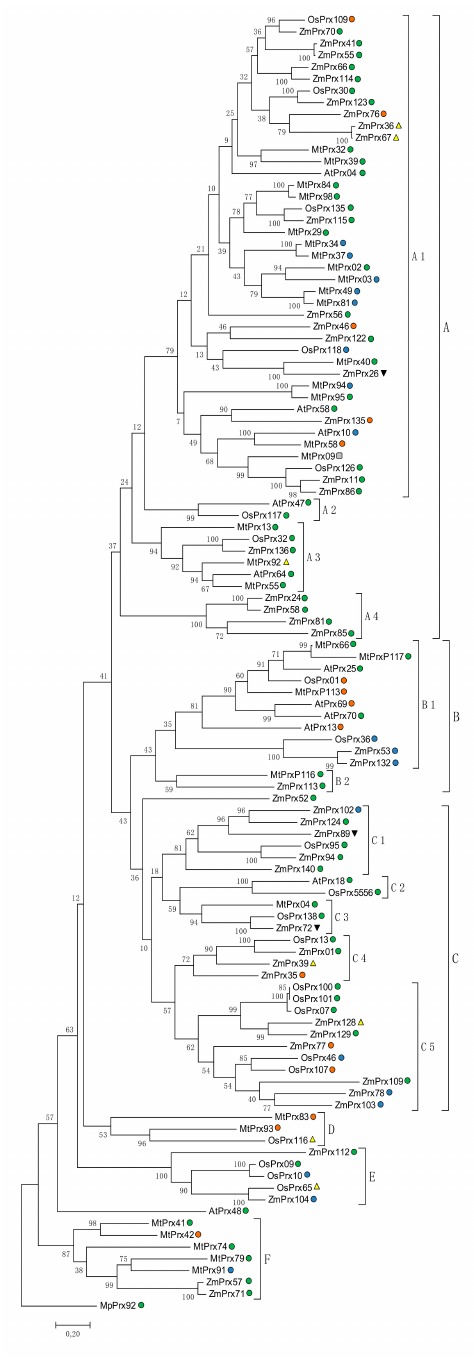
Figure 4. Phylogenetic analysis of peroxidases from Table 1 and MpPrx92 by the maximum likelihood method. The evolutionary history was inferred by using the maximum likelihood method based on the Jones, Taylor, Thornton (JTT) matrix-based model [110]. The tree with the highest log likelihood (-58984.24) is shown. The percentage of trees in which the associated taxa clustered together is shown next to the branches. Initial tree(s) for the heuristic search were obtained automatically by applying Neighbor-Join and BioNJ algorithms to a matrix of pairwise distances estimated using a JTT model, and then selecting the topology with superior log likelihood value. The tree is drawn to scale, with branch lengths measured in the number of substitutions per site. The analysis involved 110 amino acid sequences. There were a total of 841 positions in the final dataset. Evolutionary analyses were conducted by Molecular Evolutionary Genetics Analysis (MEGA7) [111]. , ER; , PM; , Vac; (cid:4) Golgi; (cid:78) , MoM; (cid:72) ,